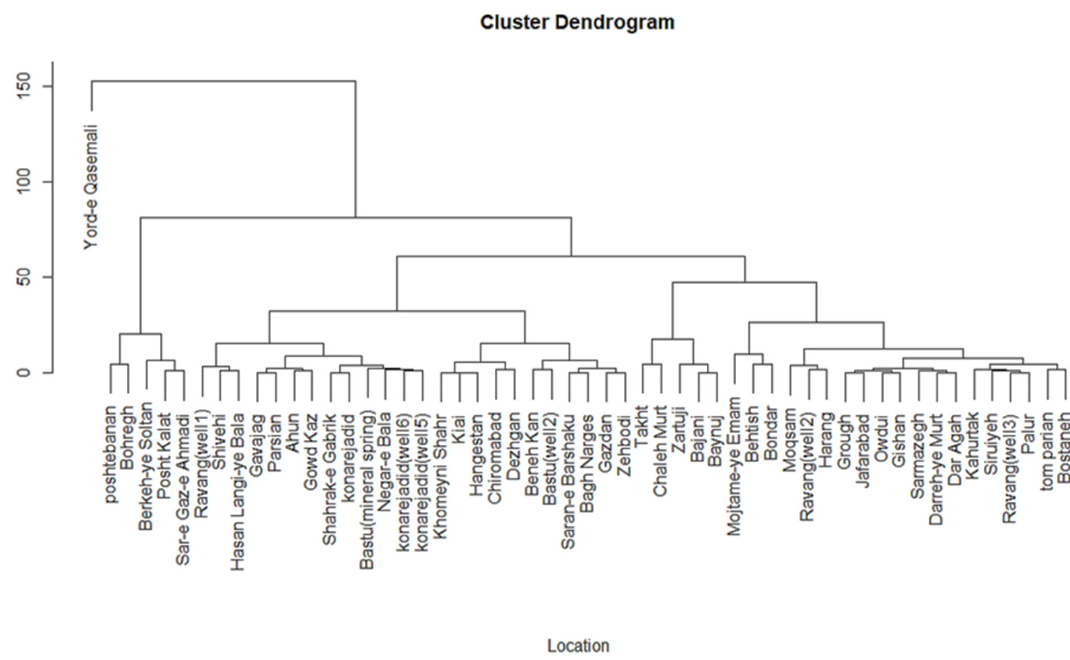
Figure 4. The hierarchical cluster analysis for the study area.